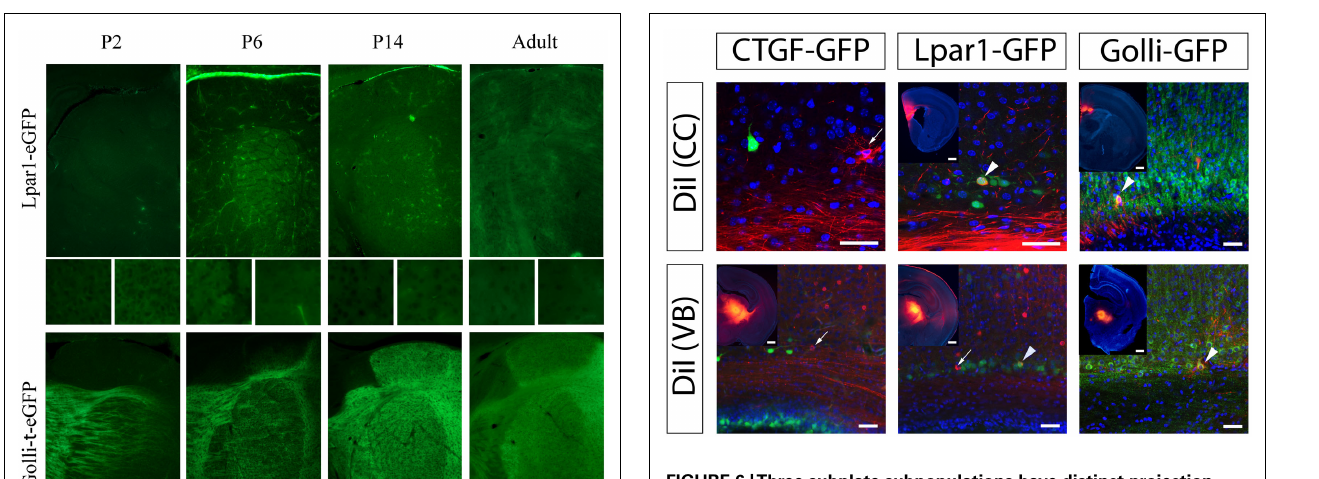
FIGURE 6 |Three subplate subpopulations have distinct projection profiles. Cortical sections, dorsal top of image, lateral is left of image. DiI back-labeling from theVB or the CC demonstrate that CTGF-eGFP labeled subplate cells are rarely-to-never back-labeled from distant structures suggesting they project locally. Insert shows DiI crystal position.The Lpar1-eGFP subpopulation is back-labeled from corpus callosum andVB; 7% of DiI + cells fromVB are Edg2-GFP + ( n = 745 cells) and 26% of DiI + cells from CC are Edg2-GFP + ( n = 114 cells).The Golli-tau-eGFP subpopulation is also back-labeled from corpus callosum andVB; 50% of DiI + cells fromVB are Golli-tau-eGFP + ( n = 65 cells), and 33% of DiI + cells from CC are Golli-tau-eGFP + ( n = 45 cells).VB, ventrobasal thalamic nucleus; CC, corpus